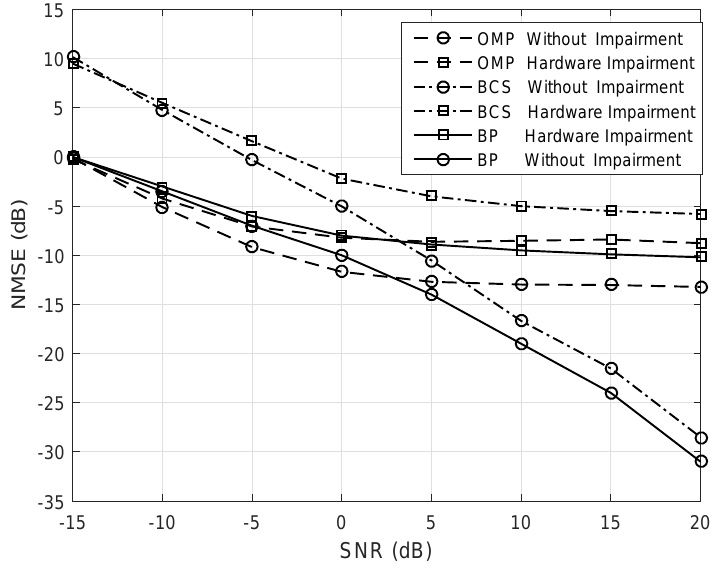
Figure 6. NMSE of the estimated CSI versus received SNR with hardware impairment = 13 dB, sparseness L = 5, angle quantization G = 32 and pilot symbol frames M =